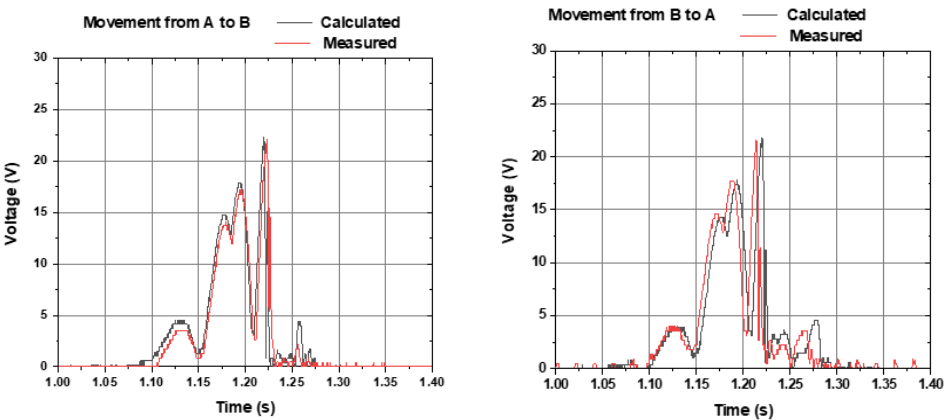
12 of 22 Figure 9. Calculated voltage (grey line) and experimentally measured voltage (red line) of the out ‐ put, within a freefall movement from coil A to coil B ( left graph ) and from coil B to coil A ( right